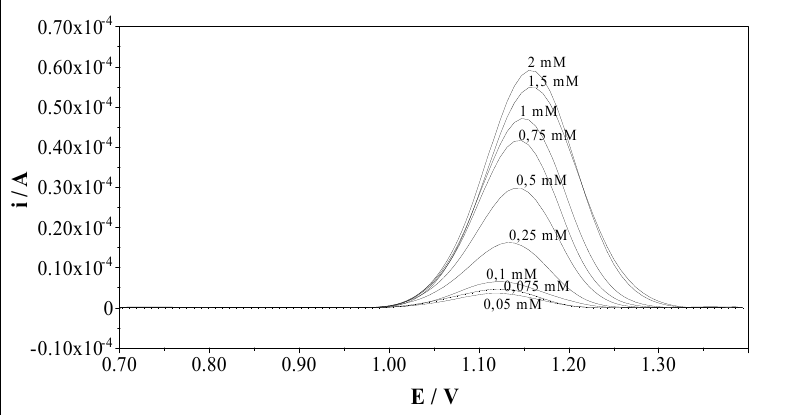
Figure 6. Differential pulse voltammograms of varying concentration at the MIP electrode at pH